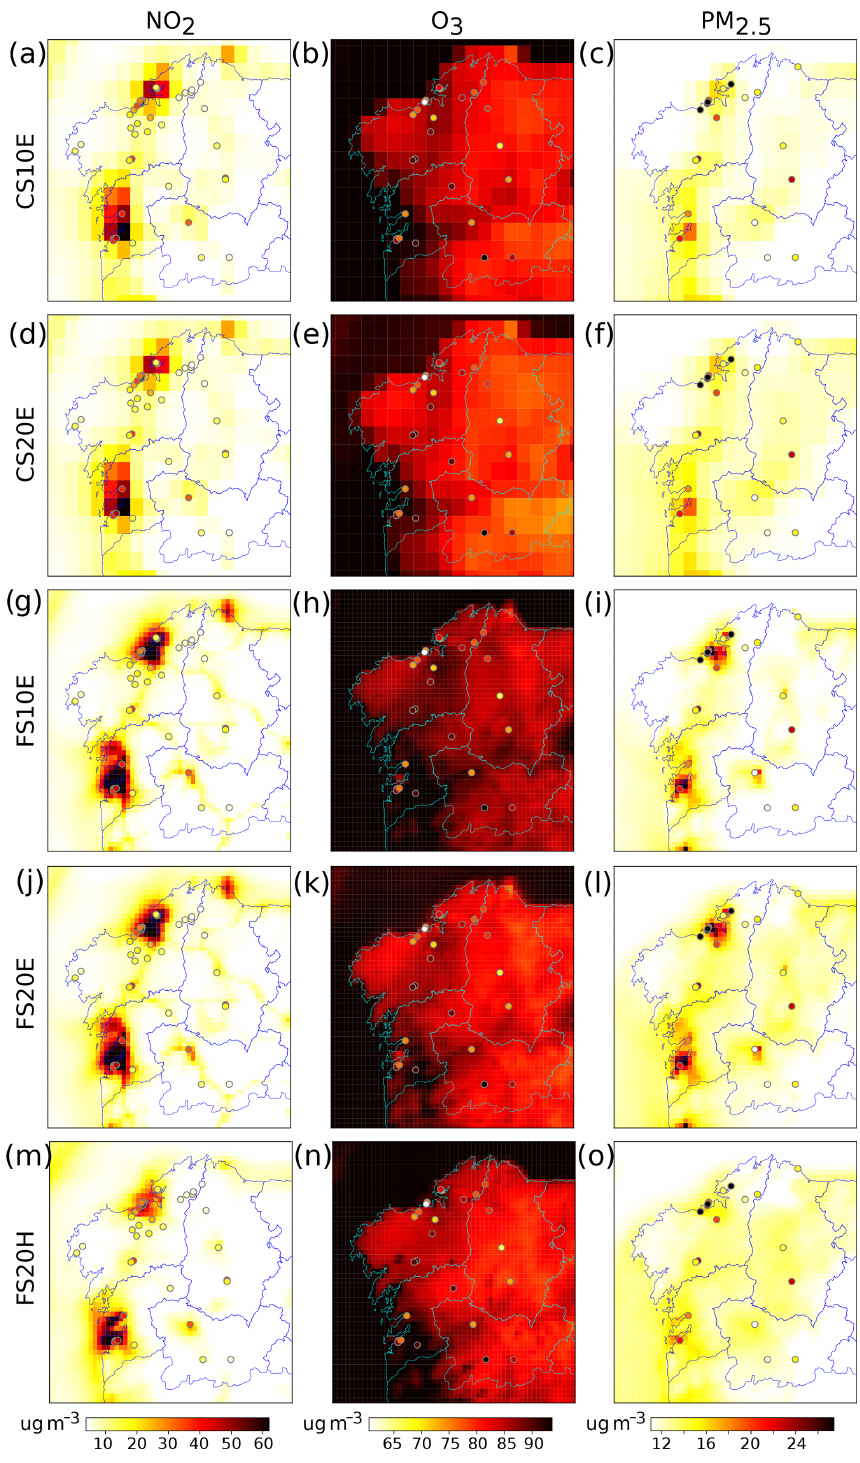
Figure 2. Observed (dots) vs. modeled (underlying pattern) temporal mean values for the daily maximum concentrations of NO 2 , O 3 and PM 2 . 5 , as well as the five experiments marked with an asterisk in Table 3, all run with the SAPRC mechanism. The spatial verification results for each panel are provided in Table